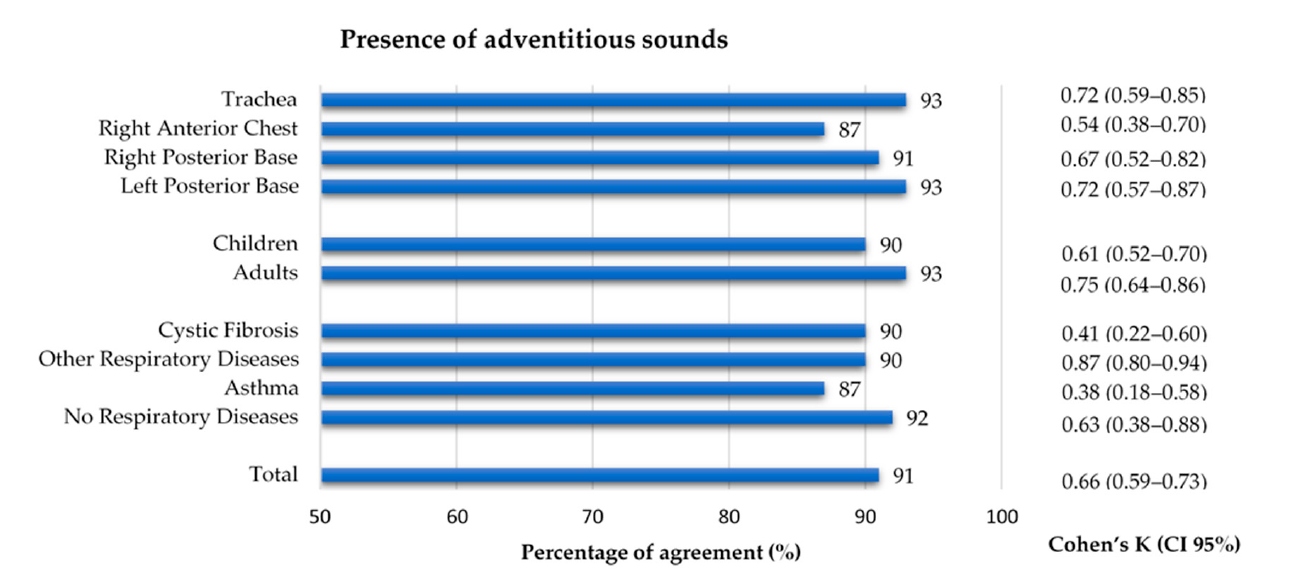
Figure 5. Percentage of agreement and inter-rater agreement on the presence of adventitious sounds in the lung sound recordings by location, age group and diagnostic group.